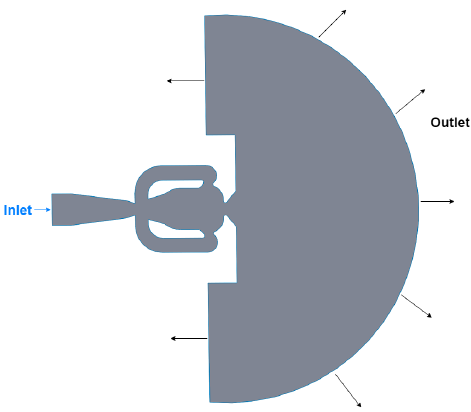
Figure 1. Computational domain of the SWJA and the flow field (baseline) showing the inlet and outlet.